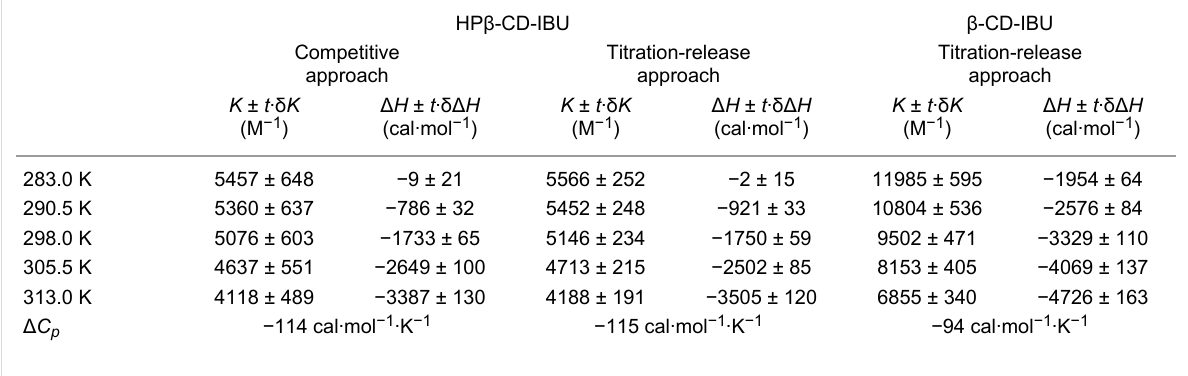
Table 3: Thermodynamic data for the HP β -CD-IBU complex obtained by a global analysis of the competitive approach and the titration-release ap- proach (considering a 5% uncertainty on each total concentration). Data for the β -CD-IBU complex correspond to the global analysis of titration- release